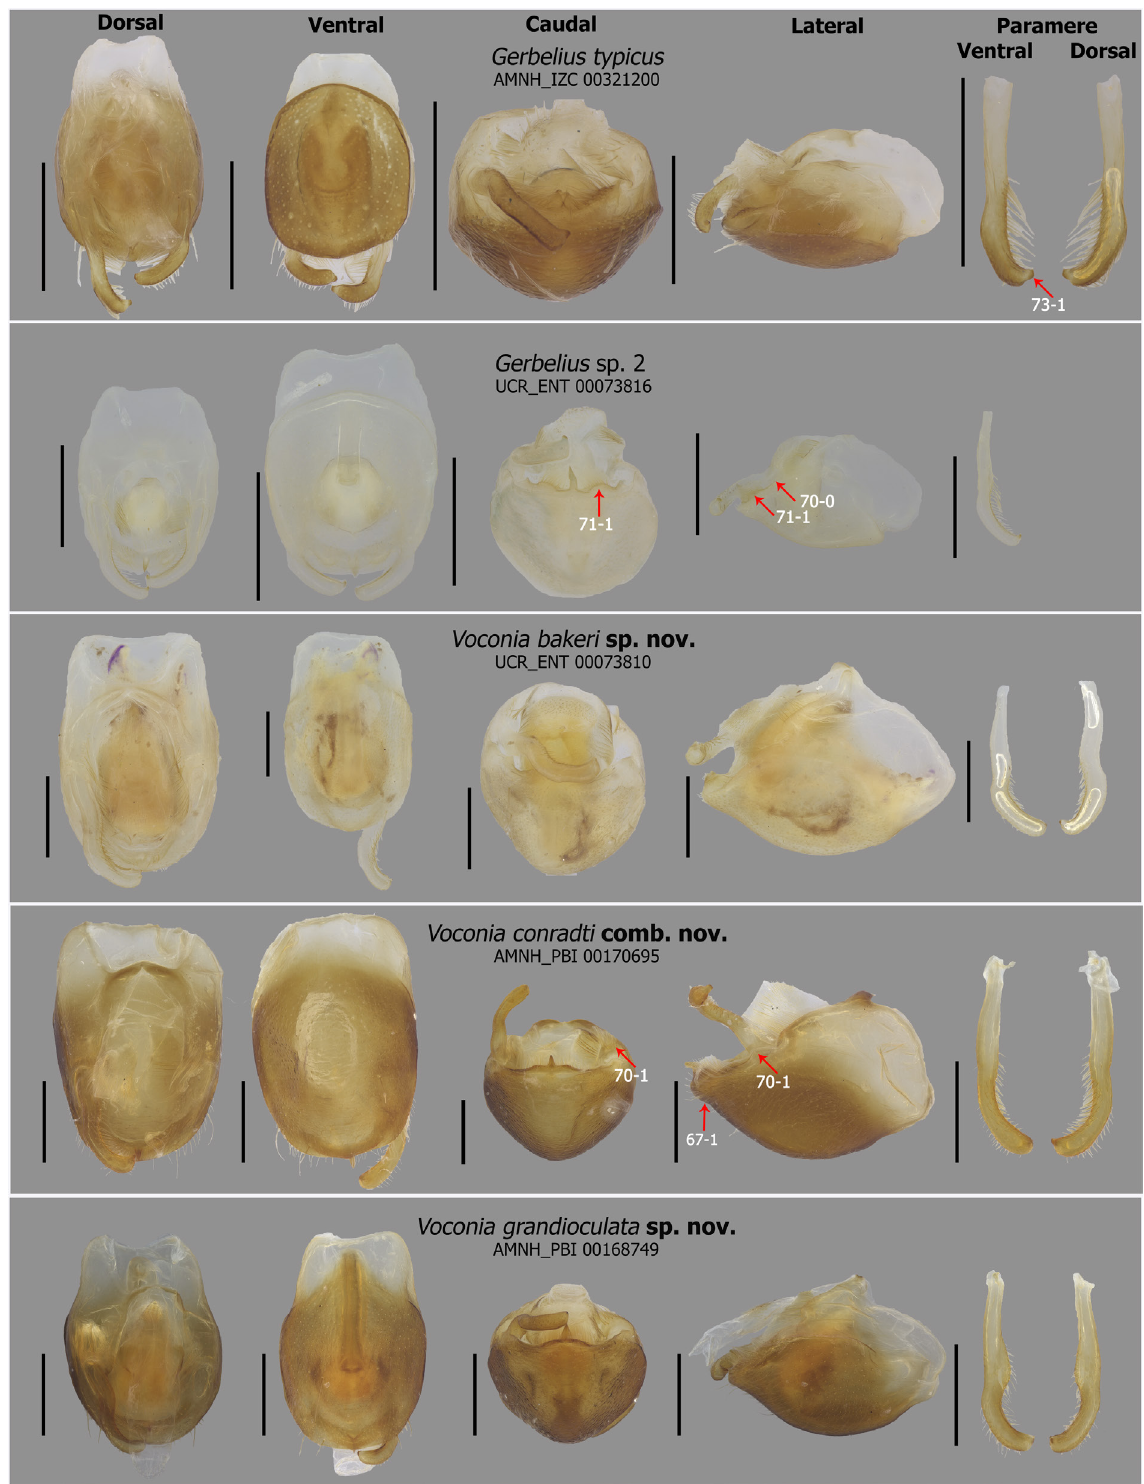
Fig. 11. Pygophore of species of Gerbelius Distant, 1903 and Voconia Stål, 1866. Median apical process of Gerbelius typicus Distant, 1903 and V. bakeri sp. nov. damaged/missing. Scale bars = 0.5